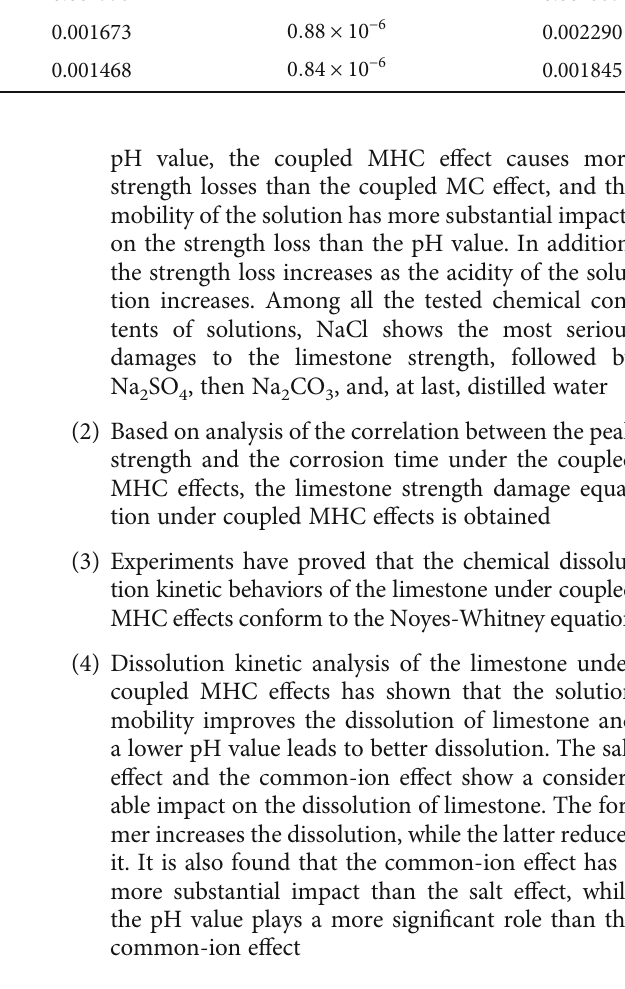
Table 10: Values of K and C